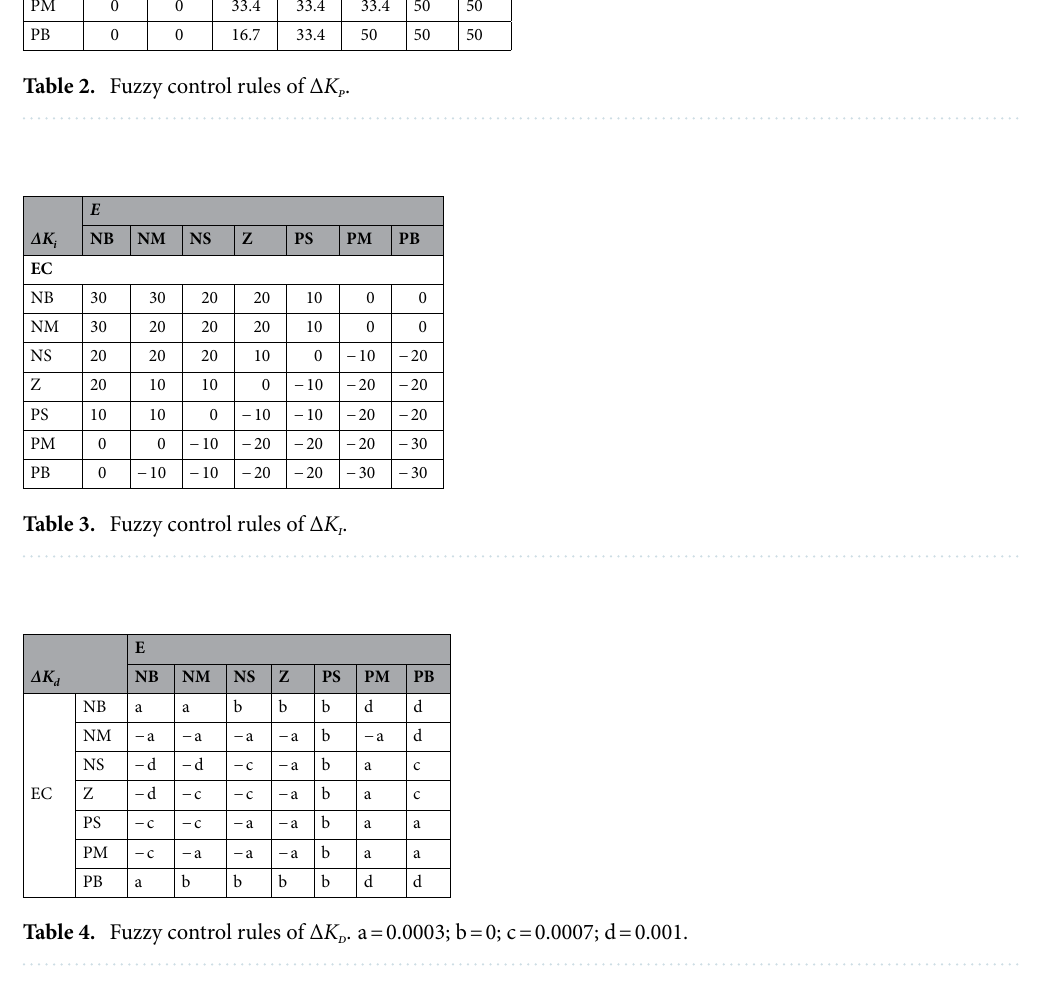
Figs. 14 and 16, the fuzzy PID control has a better stability control effect for small-signal and circuit model. So, the simulation data from fuzzy PID controller can be used as sample data. There are 1000 data sets as sample data to train the Sugeno fuzzy controller generated in the progress of designing of Sugeno Fuzyy PID controller. As one of neural network self-learning algorithm, back propagation algorithm is utilized to generate ANF PID controller.